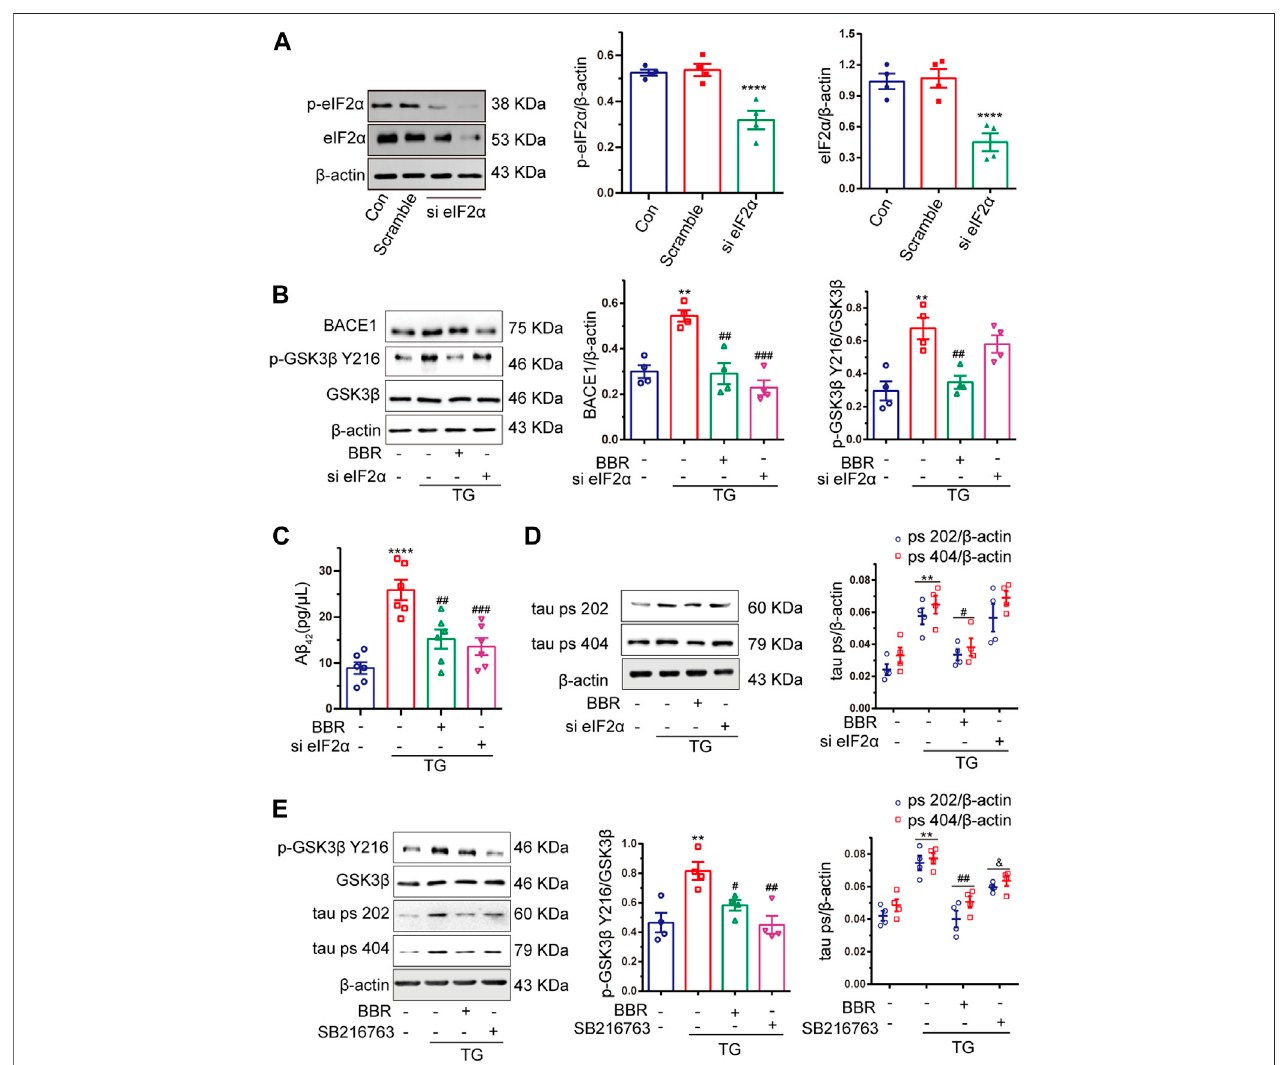
FIGURE7| BerberinedecreasesA β 42 productionbyinhibitingeIF2 α activation,buteIF2 α hadlittleeffecttoGSK3 β . (A) WesternblotdetectionofeIF2 α andp-eIF2 α in HT22 cells withsi-eIF2 α (siRNA eIF2 α ) or scramble and quantitative analysis. (B) Western blotdetection of BACE1, p-GSK3 β Y216, and GSK3 β in TG-induced HT22/ APPcellswithorwithoutsi-eIF2 α (siRNAeIF2 α )orBBRandquantitativeanalysis. (C) ThecontentsofA β 42 inTG-inducedHT22/APPcellswithorwithoutsi-eIF2 α (siRNA eIF2 α ) or BBR were detected by ELISA. (D) Western blot detection of tau ps 202 and tau ps 404 in TG-induced HT22/APP cells with or without si-eIF2 α (siRNA eIF2 α )orBBRandquantitativeanalysis. (E) Westernblotdetectionofp-GSK3 β Y216,GSK3 β ,taups202,andtaups404inTG-inducedHT22/APPcellswithorwithout SB216763 (GSK3 β inhibitor) or BBR and quantitative analysis. Data were presented as means ± SEM. * p < 0.05, ** p < 0.01, *** p < 0.001, **** p < 0.0001vs. Blank; # p